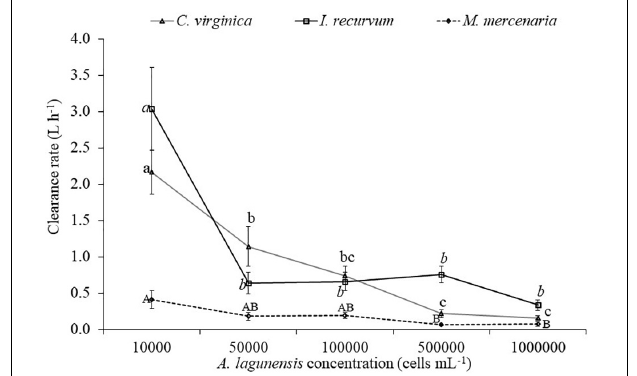
FIGURE 1 | Mean values of percentage ( ± SE) of Aureoumbra lagunensis decrease at the different algal densities (cell mL − 1 ) for each bivalve species and the control jars. TABLE 1 | Two-way ANOVA table analyzing the clearance rate of each studied species ( Crassostrea virginica , Ischadium recurvum , and Mercenaria mercenaria ) at each brown tide concentration.